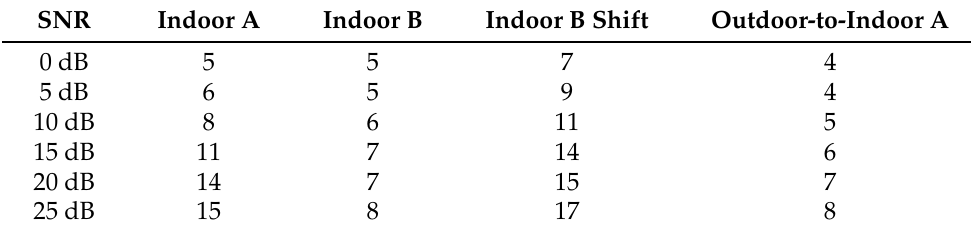
Table 5. Median values of the length U of the additional averaging filter for the particular SNRs and channel